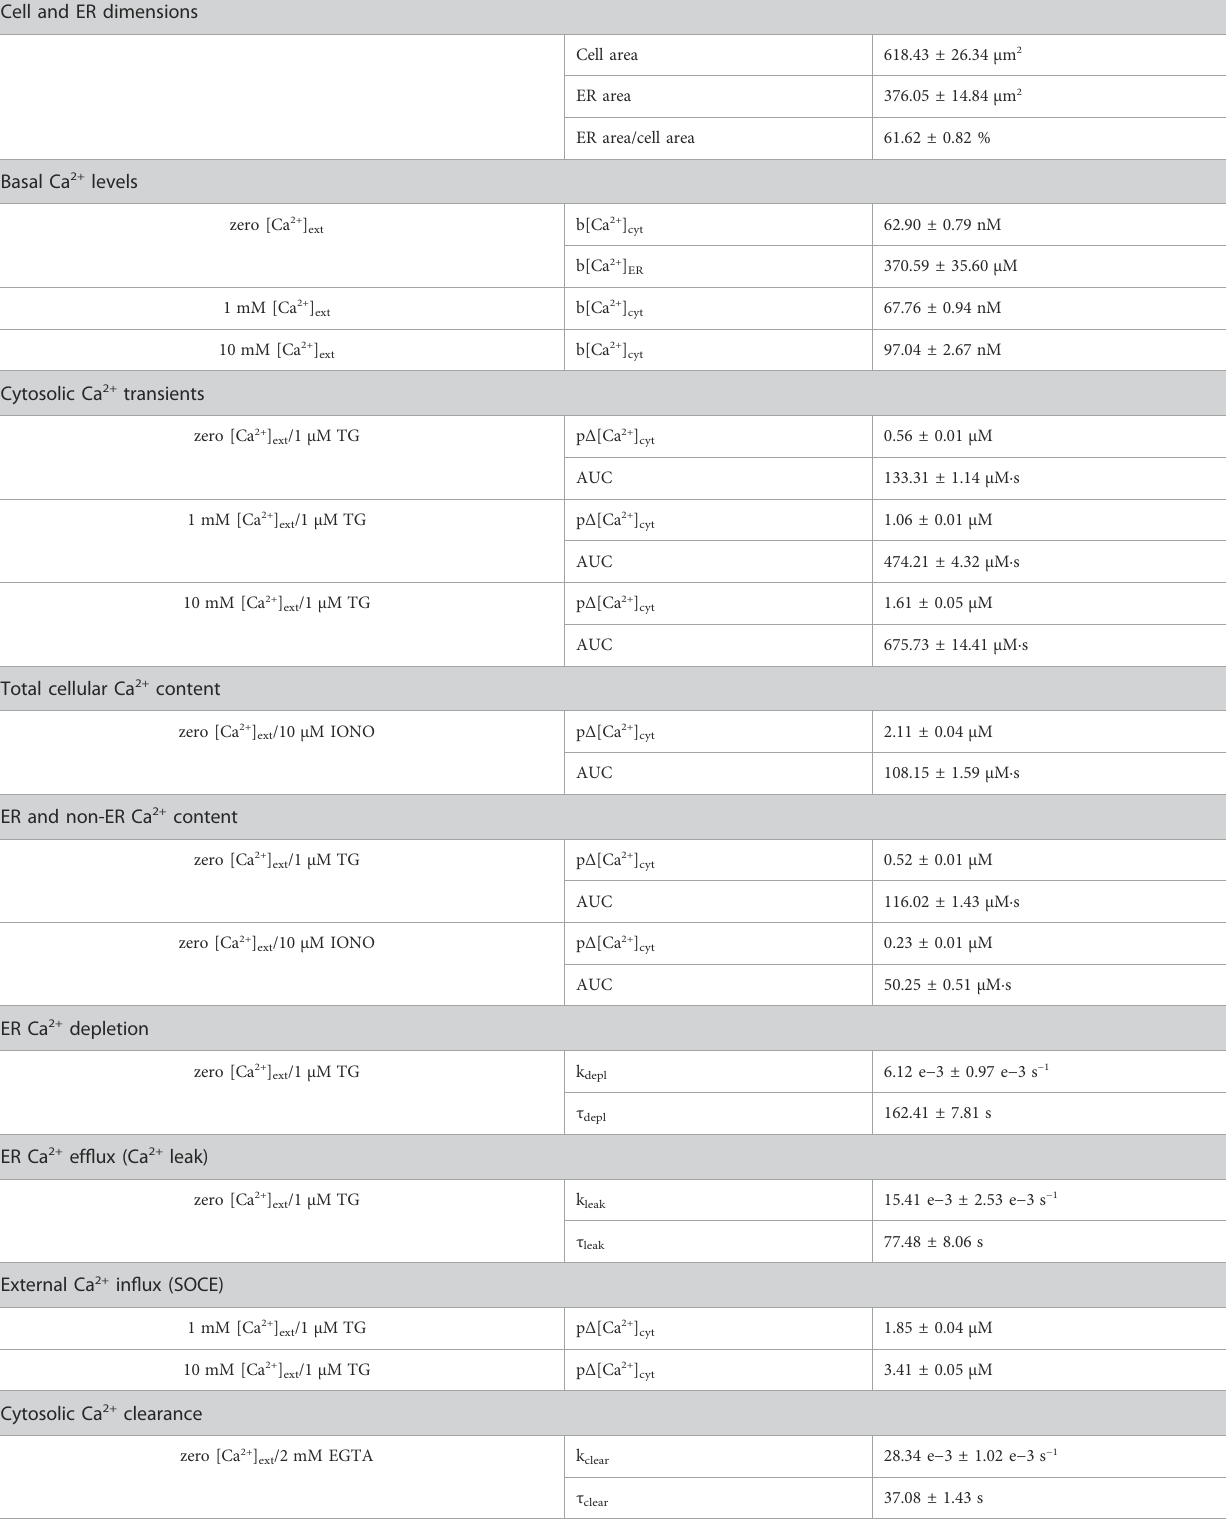
TABLE 1 Characteristic parameters of the TG-induced Ca 2+ mobilisation in HEK-293 cells. Experimental conditions, in which the parameters were obtained, are given on the left side. Cell and ER area, areas of the respective cross-sections in LSM images; ER area/cell area, ratio of ER to cell areas; TG, thapsigargin;